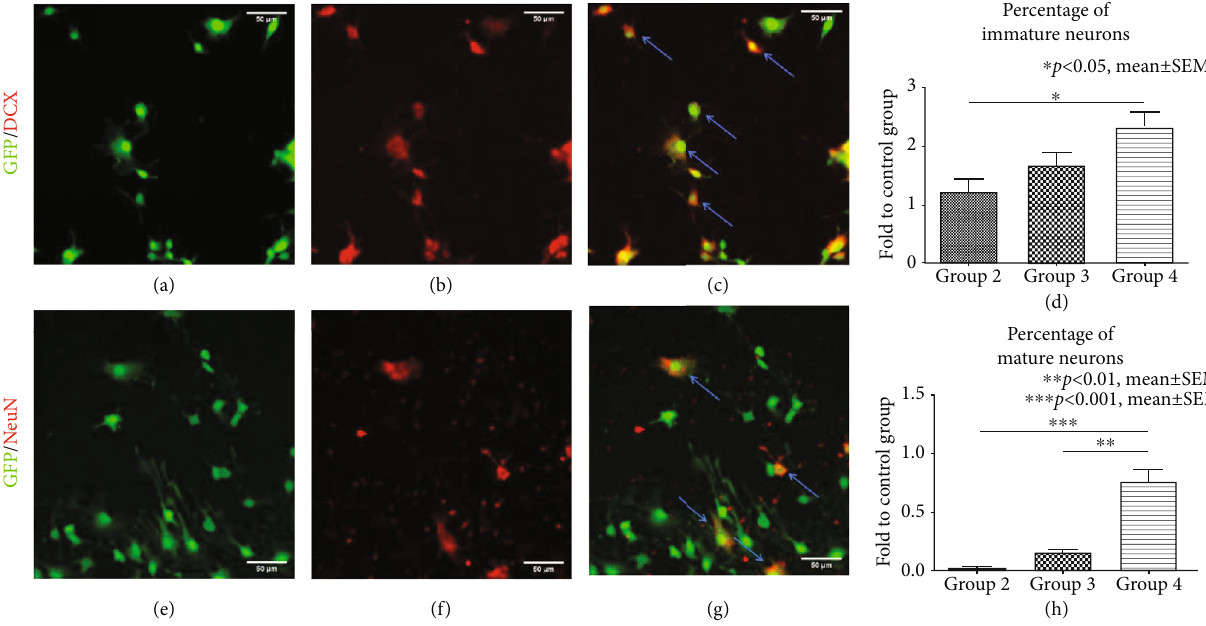
Figure 2: Di ff erentiation of NPCs towards the neuronal lineage in vitro . (a-c) Costaining of GFP + /DCX + cells (blue arrows) indicating neuronal precursors. (d) Quanti fi cation of neuronal precursors after 7 days of incubation with the di ff erent growth factor concentrations/combinations in groups 2-4, expressed in proportion to (fold to) the control group (group 1). (e-g) Costaining of GFP + /NeuN + cells (blue arrows) indicating mature neurons. (h) Quanti fi cation of mature neurons after 7 days of incubation with the di ff erent growth factor concentrations/combinations in groups 2-4, expressed in proportion to (fold to) the control group (group